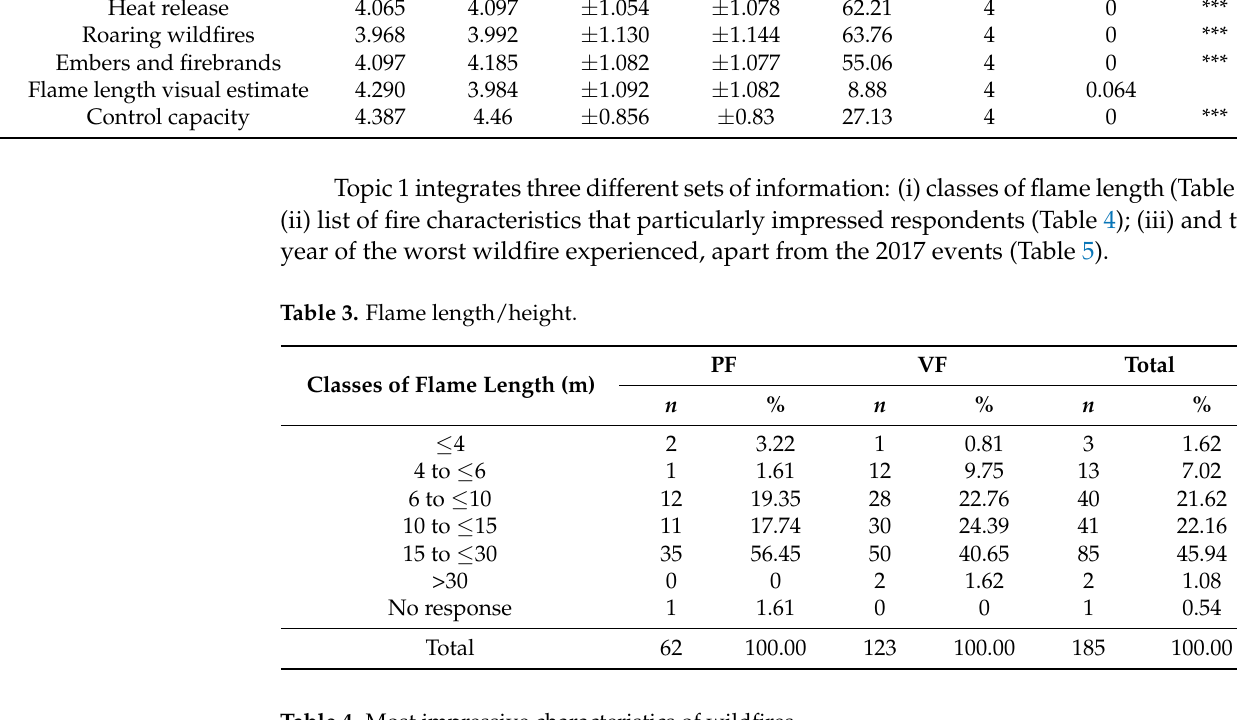
Table 2. Facing the inferno (perception of the fire event) PF vs. VF ( n = 185).